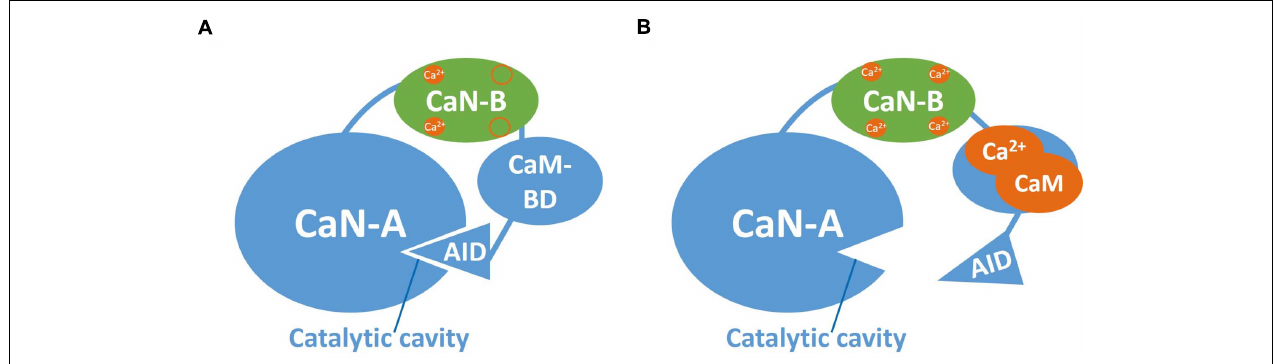
FIGURE 2 | Calcineurin structure. (A) Inactivated CaN. Representation of CaN-A catalytic subunit (blue) and the regulatory subunit CaN-B (green). CaN-A consists of a catalytic cavity, a CaN-B binding domain, a calmodulin binding domain (CaM-BD) and an autoinhibitory domain (AID). CaN-B possesses four binding sites for Ca 2 + , two of high affinity typically occupied by Ca 2 + at basal levels. The AID occupies the catalytic cavity when CaN is inactive. (B) Activated CaN. At low Ca 2 + influx, Ca 2 + binds to the low affinity sites at CaN-B and the Ca 2 + /CaM complex binds to CaM-BD allowing AID removal from the catalytic